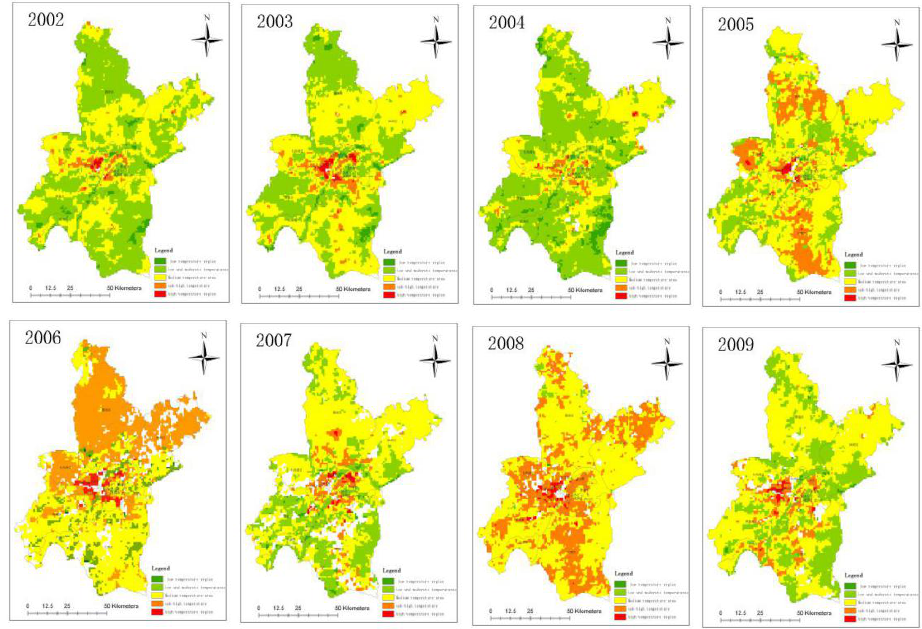
Fig. 2 Distribution Map of July Heat Island Area in Wuhan